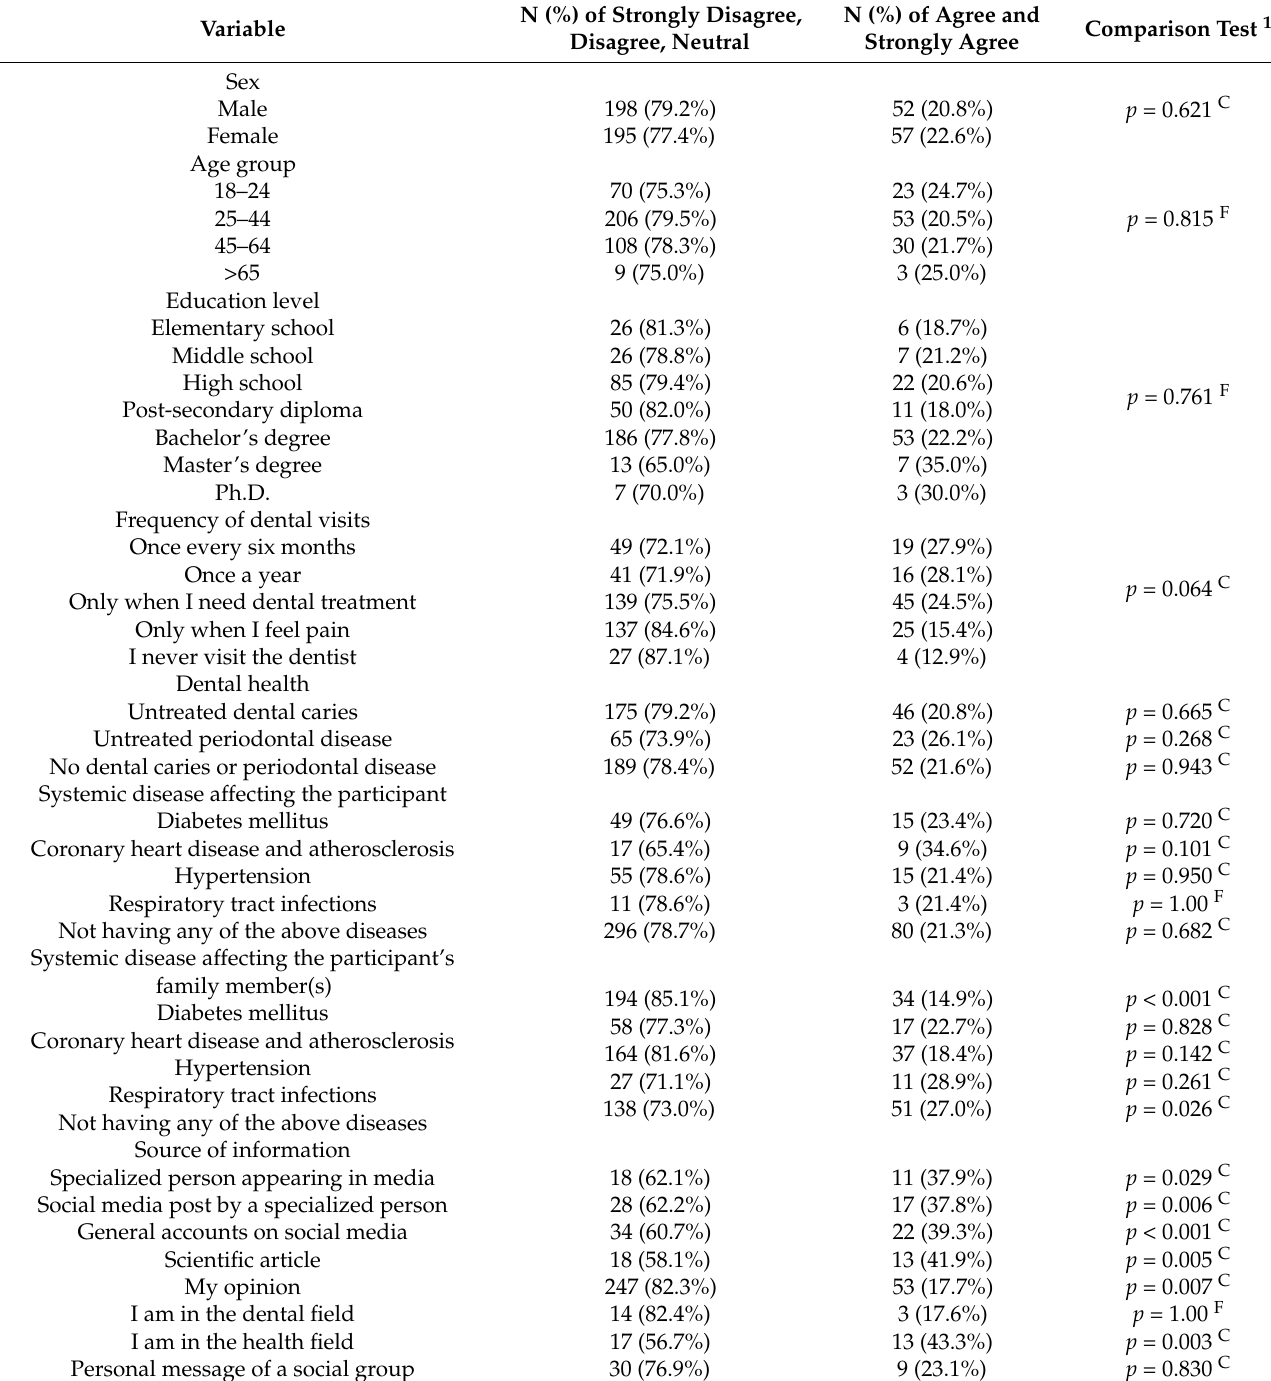
Table 15. Awareness about the association between periodontal disease and respiratory tract infec- tions distributed by various